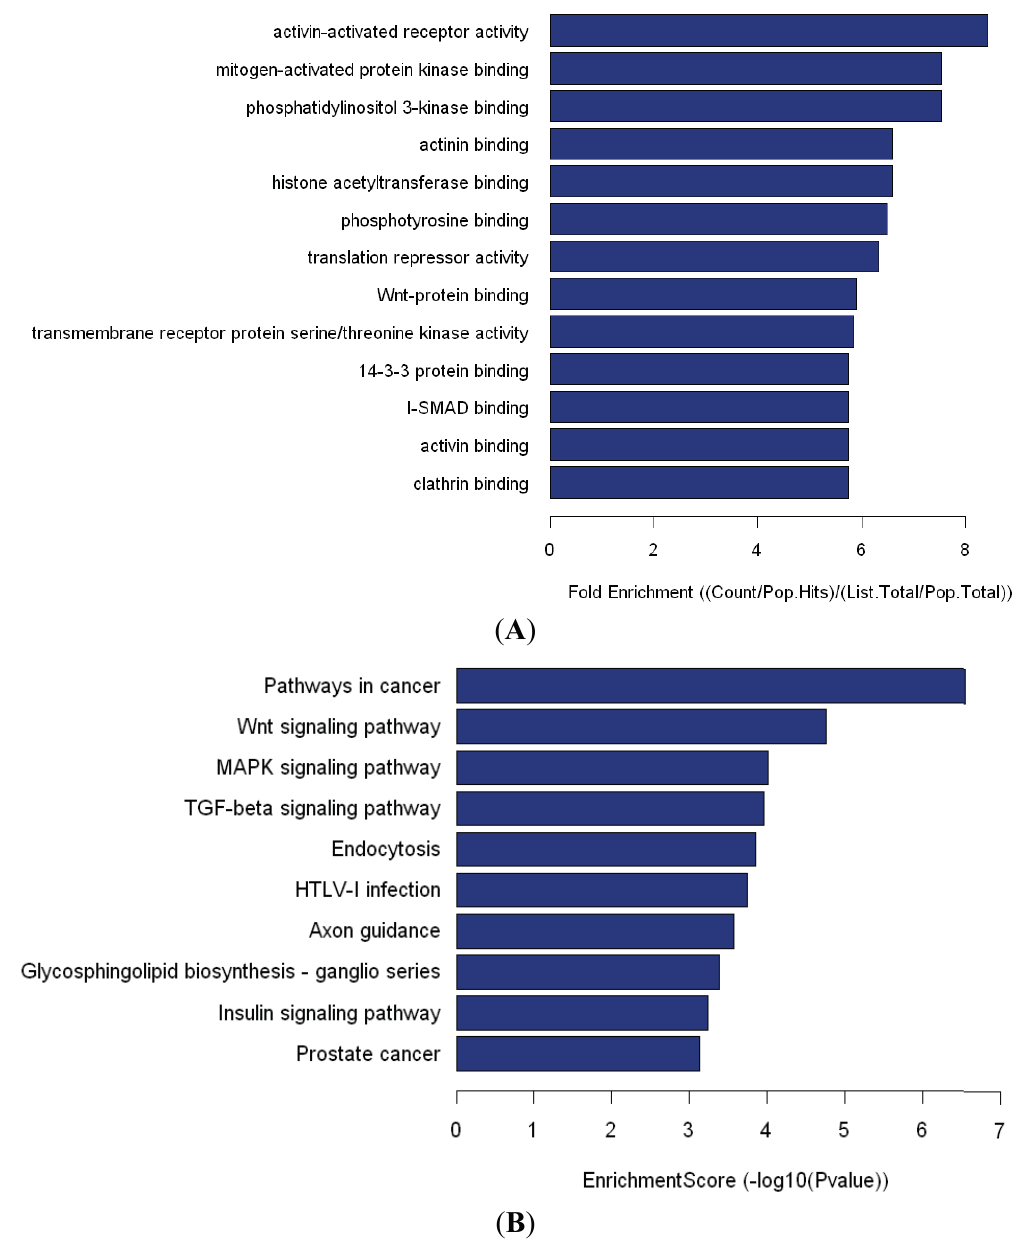
Figure 2. Molecular function of Go analysis of miR-548ah target gene ( A ); Pathway analysis of miR-548ah target gene ( B